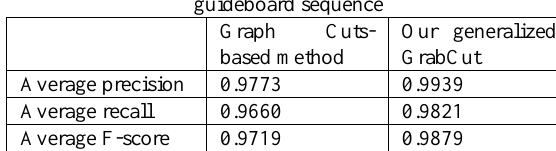
Table 1. Average precision, recall and F-score of the brown